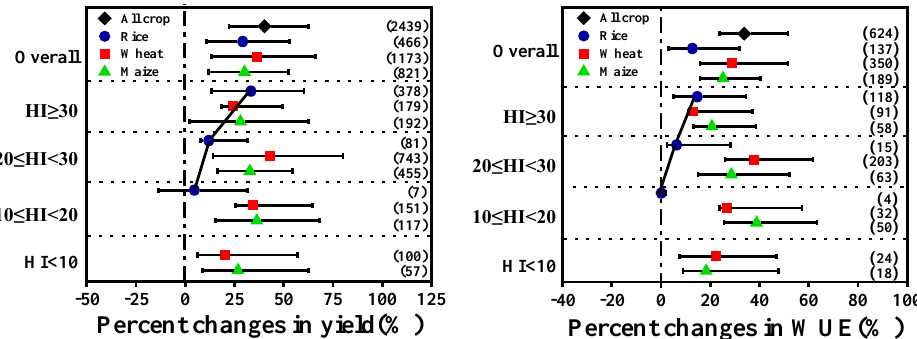
Figure 8. Percent changes in crop yield and WUE with field management practices under four levels of HI for maize, wheat, and rice, expressed as the mean value with bias-corrected 95% confidence intervals. Observation numbers for each group are given in parentheses.